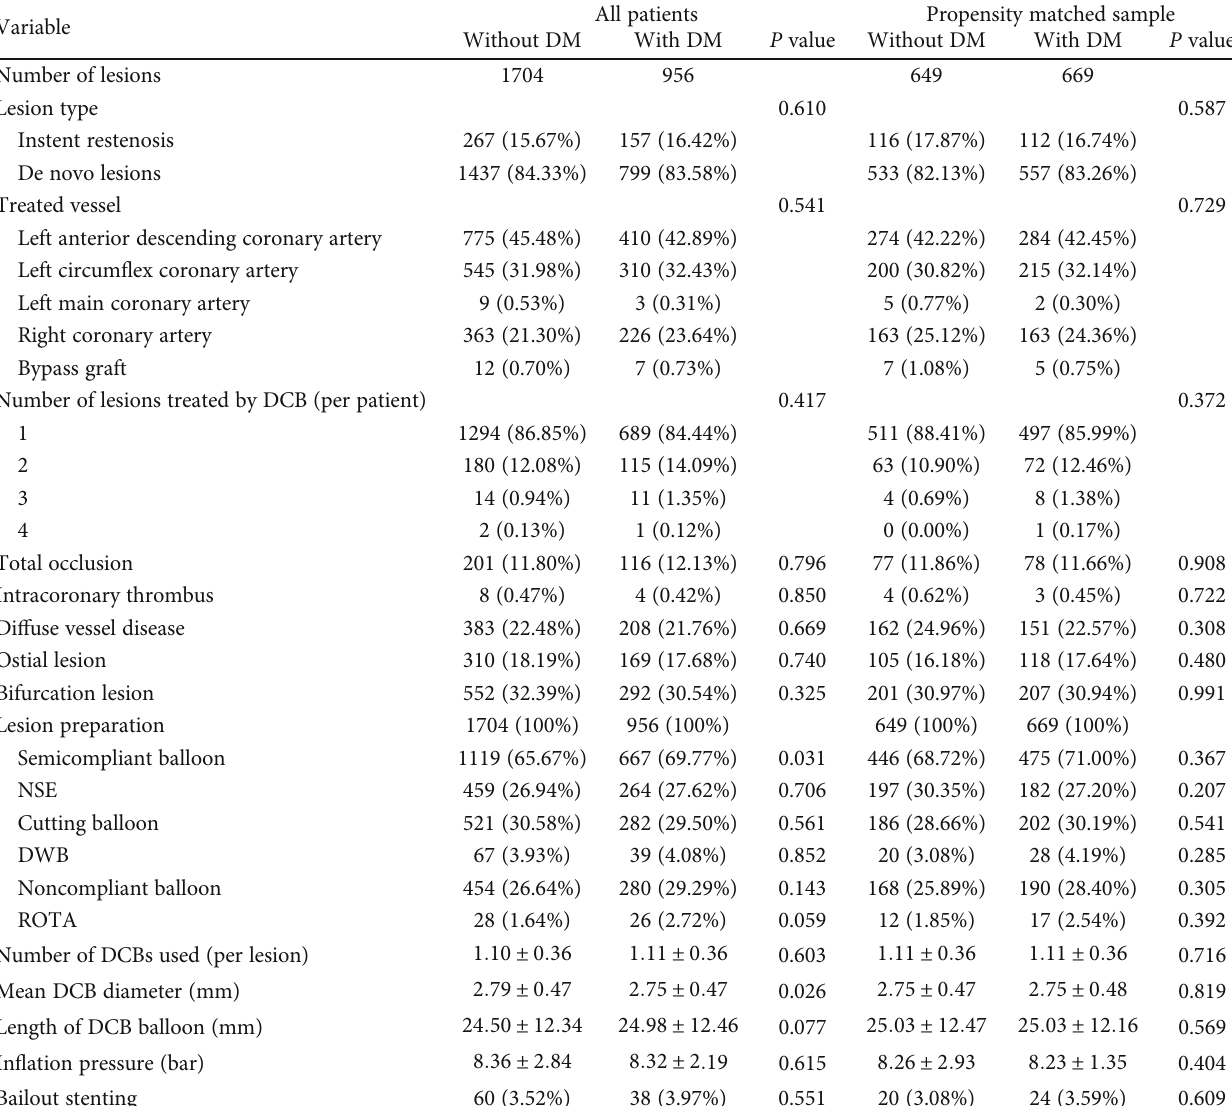
Table 2: Procedural characteristics before and after propensity score matching.